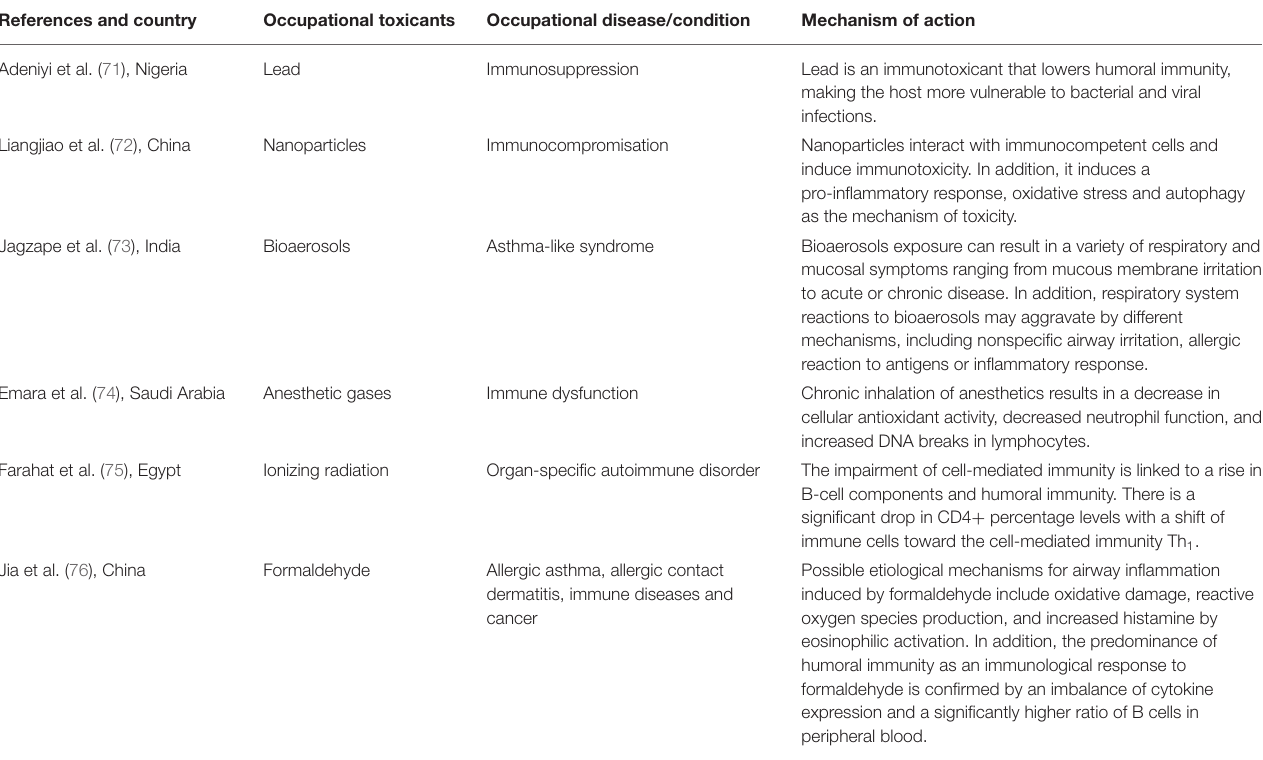
TABLE 1 | The types of occupational toxicants related to the immune system. References and